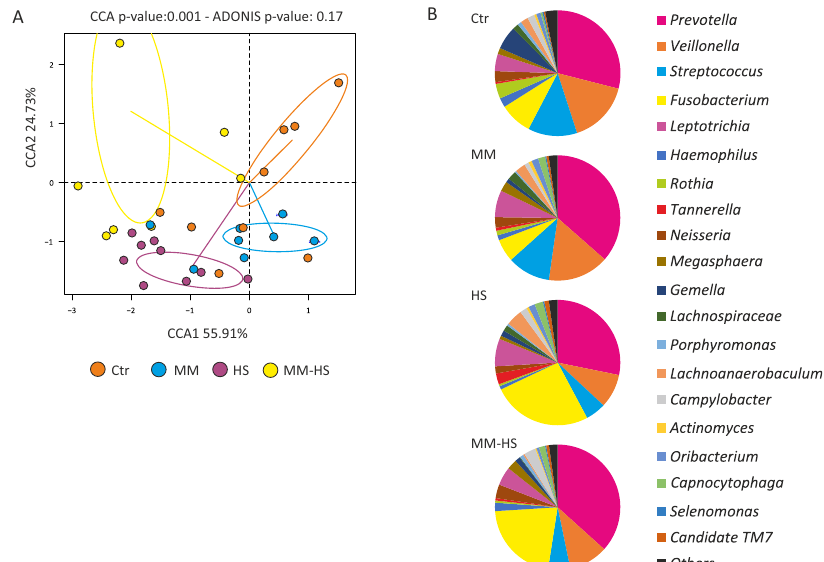
Fig. 2 Pro fi les of active microbiota in healthy and halitosis groups. Active microbiota composition, as determined by the metatransciptomic data, was compared between groups in a CCA plot using ADONIS test A . The pie charts represent the top-20 most abundant genera in each group B . Ctr Control group, MM methyl mercaptan group, HS hydrogen sul fi de group, MM-HS methyl mercaptan + hydrogen sul fi de group (both gases over the halitosis threshold). The CCA p -values (ADONIS permanova) indicated that all groups differed signi fi cantly from each other ( p < 0.007), except Ctr and MM ( p =